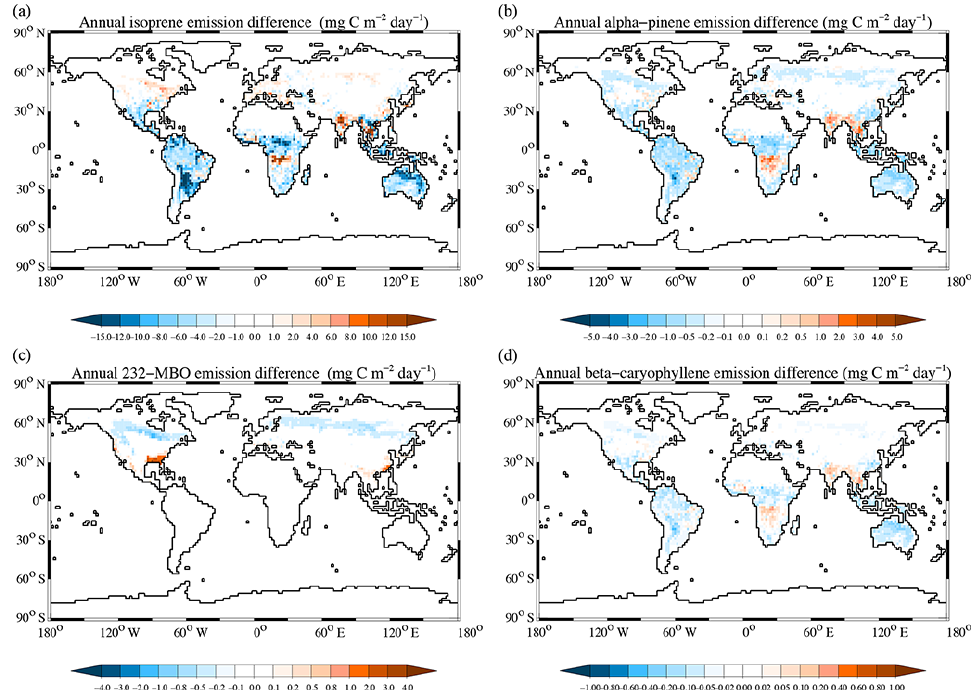
Figure 9. Difference in annual emissions (mgCm − 2 day − 1 ) between the PFT-JSBACH and PFT-CLM4 simulations for (a) isoprene, (b) α - pinene, (c) 232-MBO, and (d) β